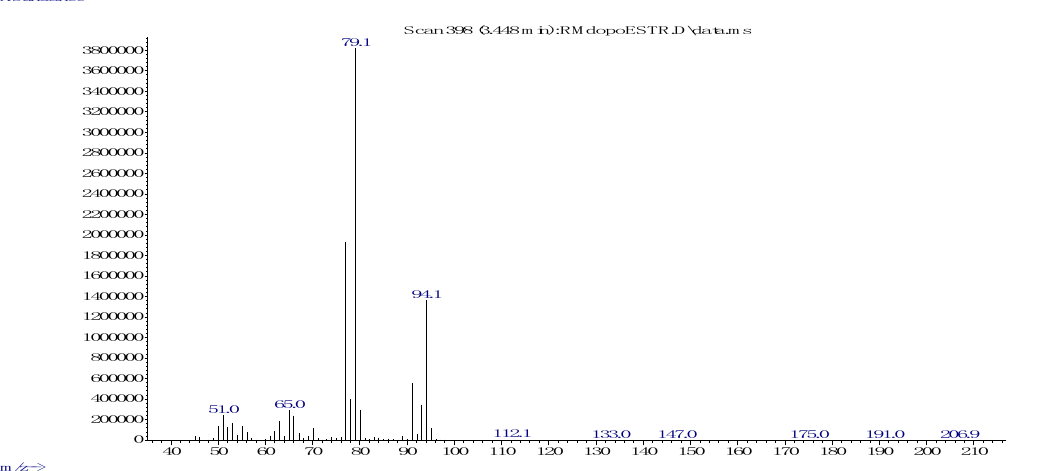
Figure A2 . MS spectrum of 3-ethylidene-1-cyclopentene r.t 3.45. Figure A2. MS spectrum of 3-ethylidene-1-cyclopentene r.t 3.45.